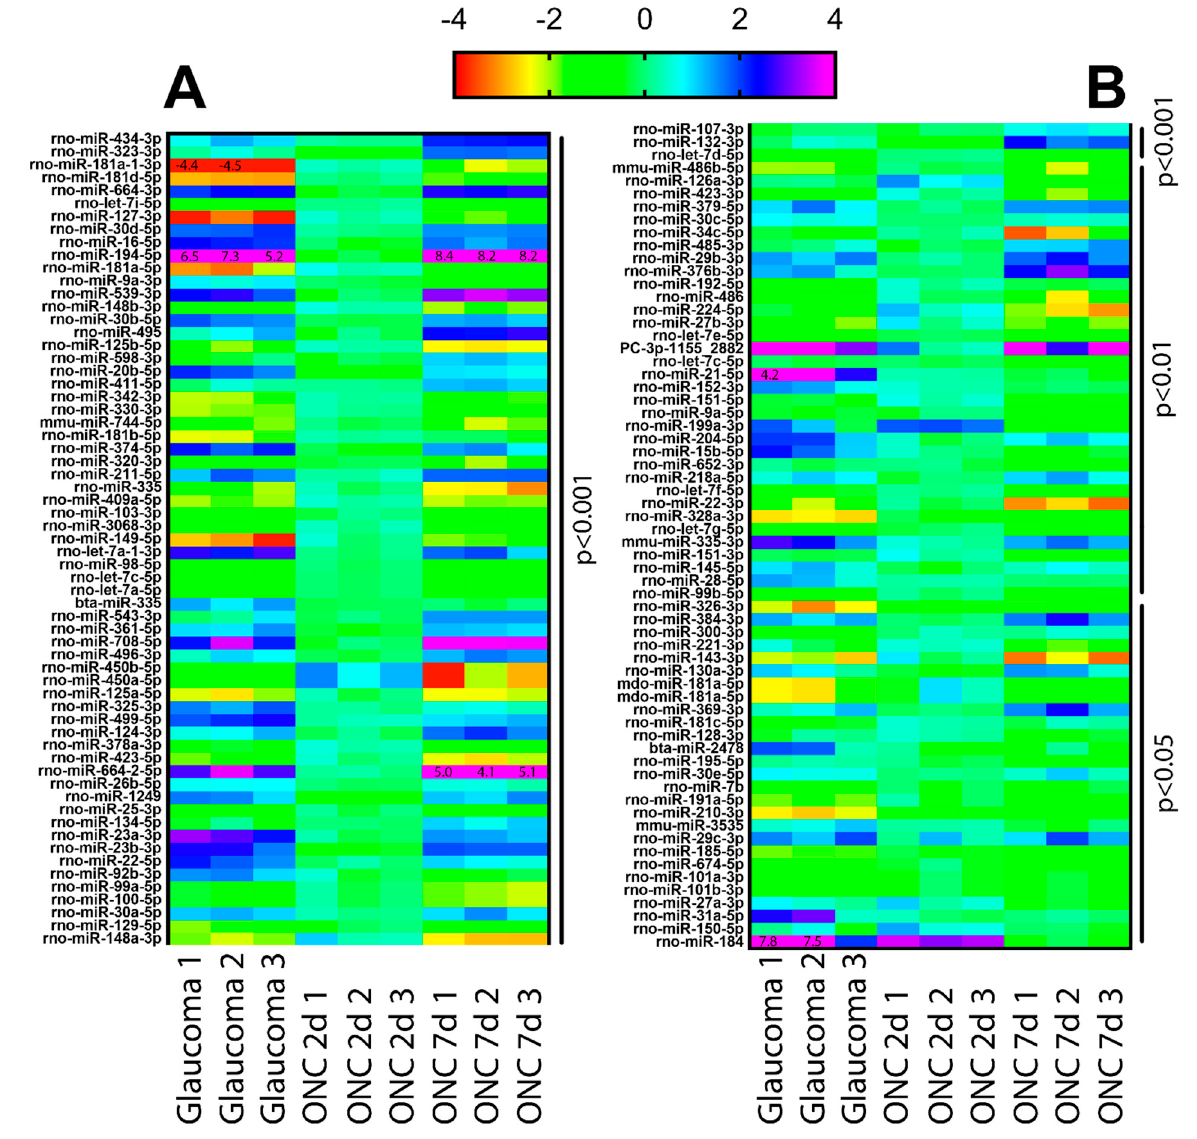
Figure 2. miRNA fold change heat map profile. The miRNA profile of purified RGC in diseased retina, displayed as a heat map of the log 2 -fold change in comparison with RGC from healthy/uninjured retina. Red/yellow indicates a lower abundance in comparison to healthy RGC whereas blue/purple indicate a comparatively higher abundance. The 14 values that exceed the scale are labelled directly. Only miRNA that are significantly different from their abundance in healthy RGC are shown, with the p values ( p < 0.001 in Panel A ; p < 0.01/0.05 in Panel B ) given to the right of the heat maps.